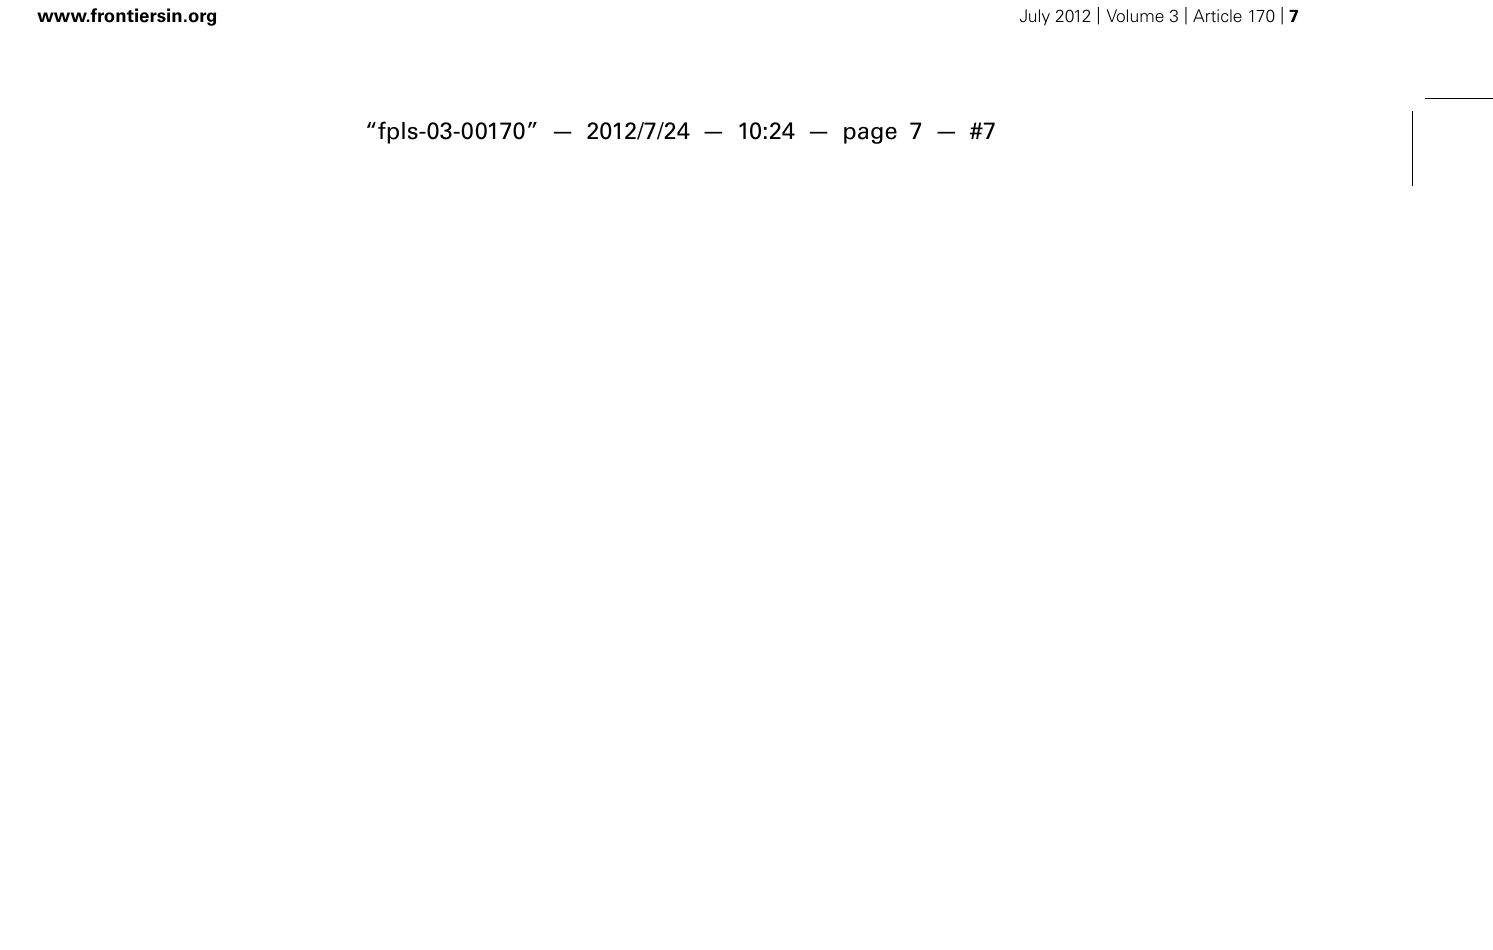
SmaCC/MASC compartments, which are known to interact with microtubules, a step required for the insertion of CesA into the plasma membrane.The proteins mediating the interaction between SmaCC/MASC and microtubules are partially known (indicated by question mark) and FRA1/BC12 might putatively be part of such complex. As a further hypothesis, FRA1 and BC12 might be part of the complex that organize the nascent cellulose microfibrils at the plasma membrane interface by delivering specific components that regulate the orientation of cellulose microfibrils (indicated by